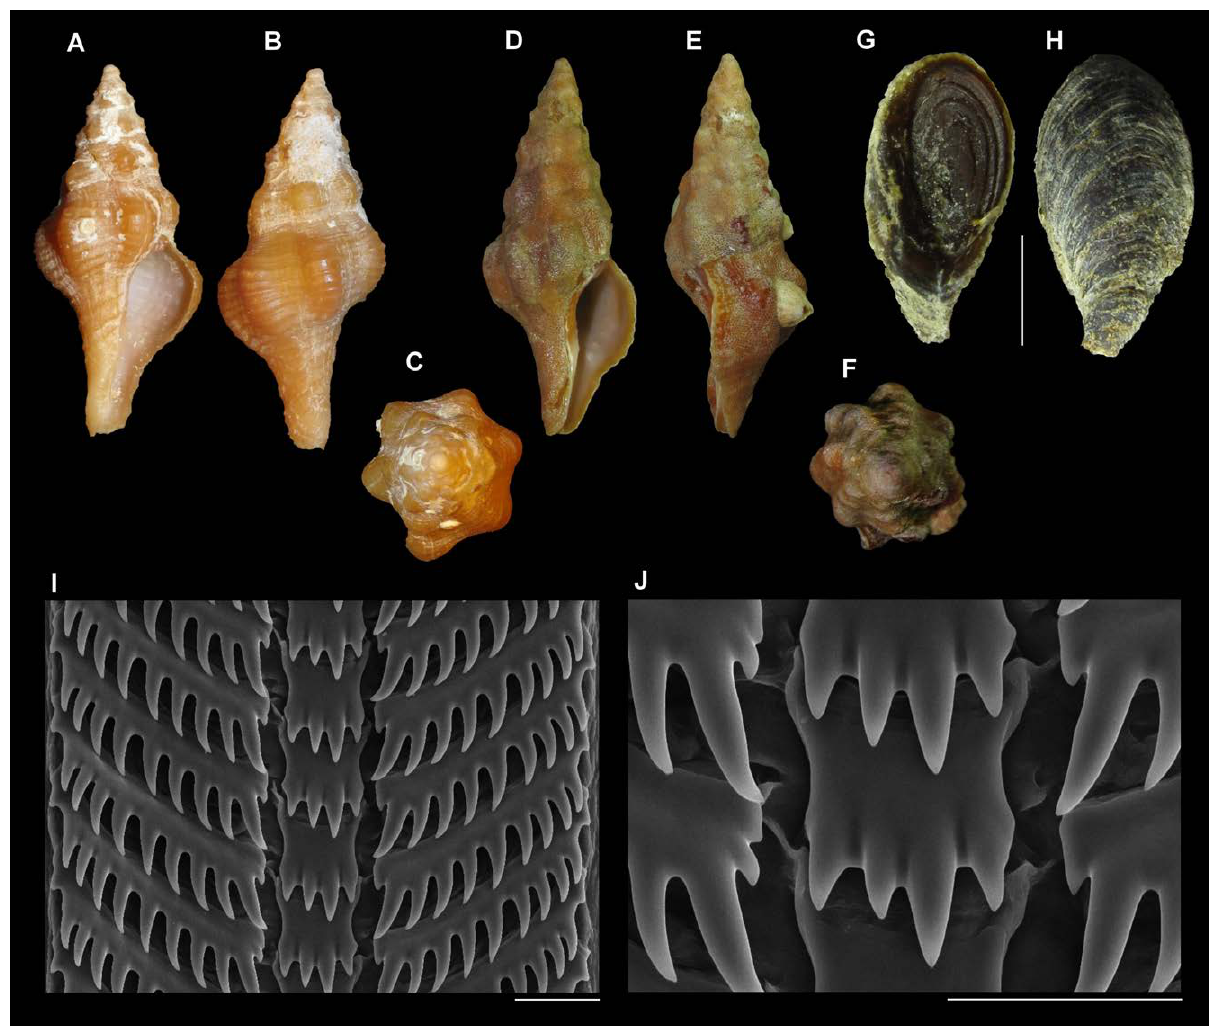
Fig. 1. – Pustulatirus ogum . A-C, 22.2 mm (MZSP 68475); D-F, 39.2 mm (MZSP 69301); G, operculum internal view; H, operculum external view; I, radula; J, detail of rachidian tooth. Scale bars: G-H, 3 mm; I-J, 30